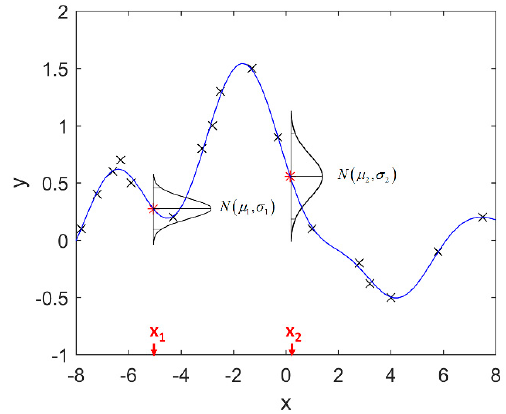
Figure 1. An example of GP modelling and prediction.